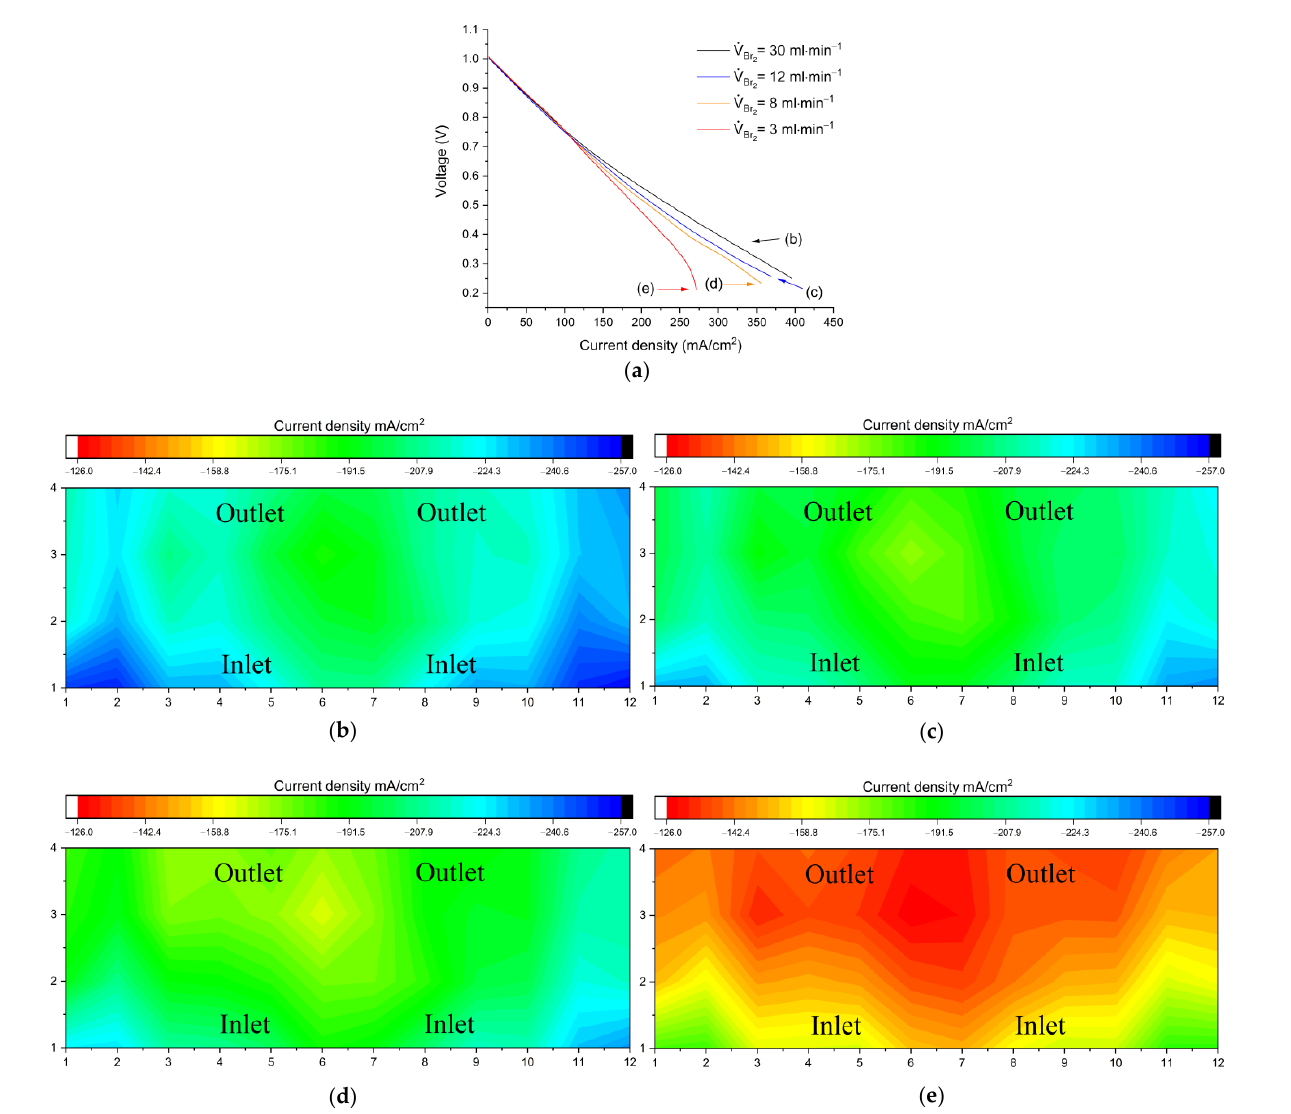
Figure 6. ( a ) Polarization curves (discharge) for different catholyte flow rates and corresponding current distributions at limiting conditions for ( b ) V Br2 = 30 mL min − 1 , ( c ) V Br2 = 12 mL min − 1 , ( d ) V Br2 = 8 mL min − 1 , and ( e ) V Br2 = 3 mL min − 1 . The supply of H 2 was fixed to V H2 = 170 mL min − 1